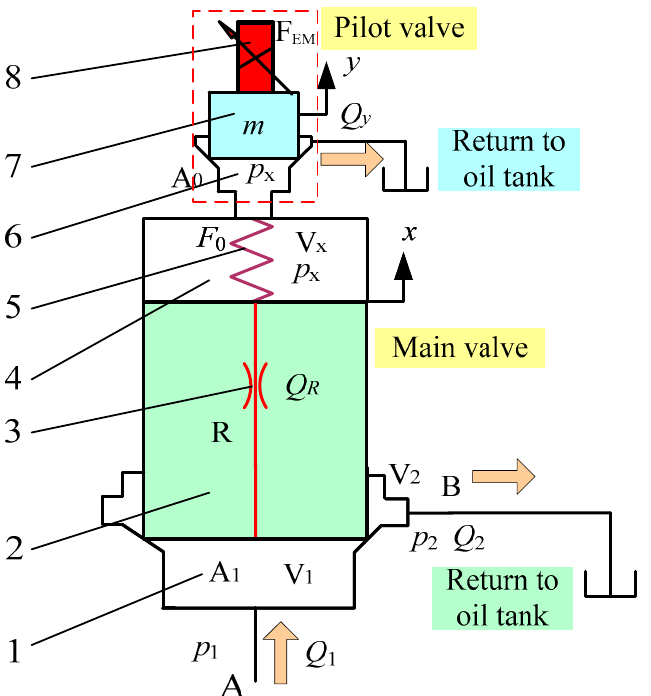
Figure 4. Simplified structure diagram of traditional proportional relief valve. 1—front chamber of main valve core, 2—main valve core, 3—fixed damping, 4—spring cavity, 5—return spring, 6—front chamber of pilot valve core, 7—pilot valve core, 8—proportional electromagnet.